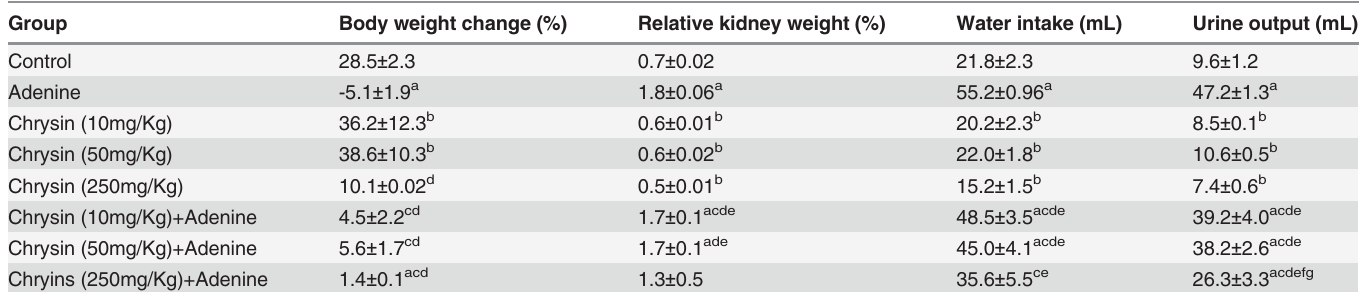
Table 1. Effect of chrysin treatment on some physiological parameters in rats with adenine-induced chronic kidney disease. Group Body weight change (%) Relative kidney weight (%) Water intake (mL) Urine output (mL) Control 28.5 ±